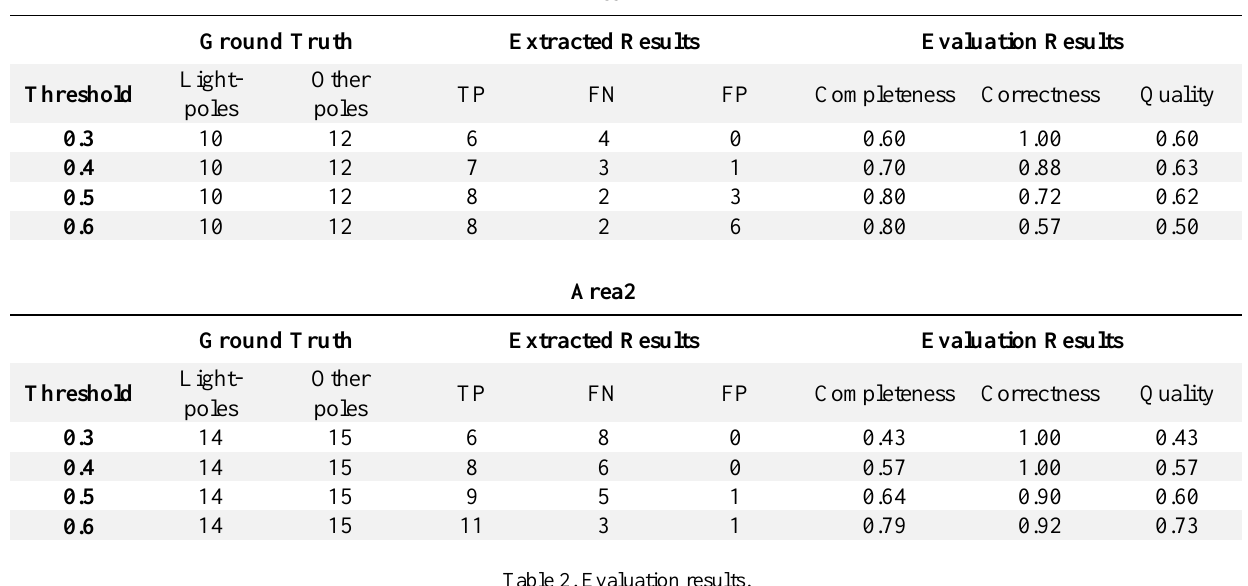
Table 2. Evaluation